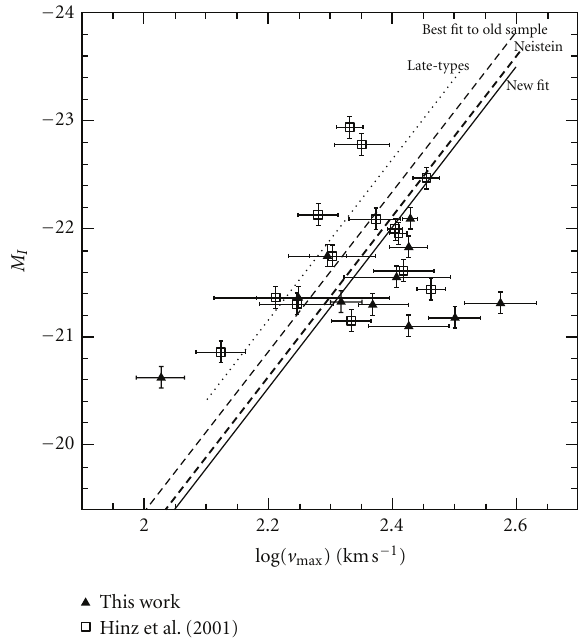
Figure 12: Tully-Fisher diagram for S0 Coma galaxies in I-band. The dotted line indicates the TF for late-type spirals and the full line shows the TF of S0 galaxies from the Coma cluster. Credit: Hinz et al. [162]. Reproduced by permission from the